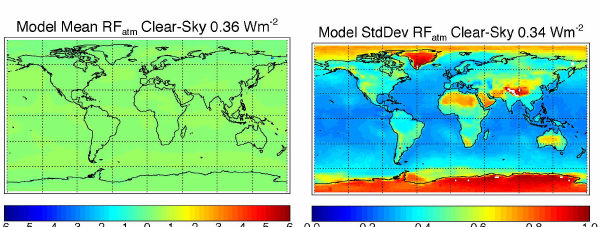
Fig. 8. Annual mean short-wave clear-sky top-of-atmosphere radia- tive forcing between experiments with AOD=0.2 and AOD=0.0 distributed over the lowest two kilometers, holding SSA=0.8 and ANG=1.0 constant